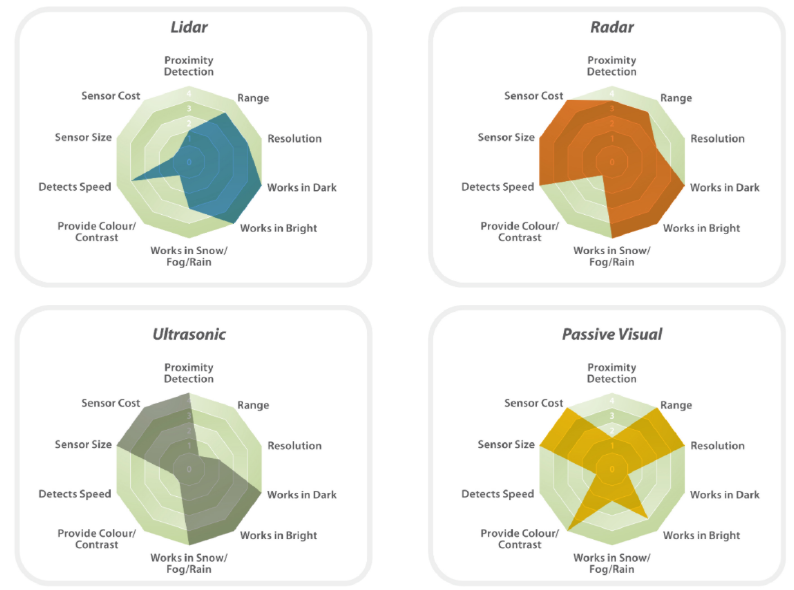
Figure 20. Spider diagrams showing strengths of various sensors found in automobiles. (Image source: www.cleantechnica.com; accessed on 12 March